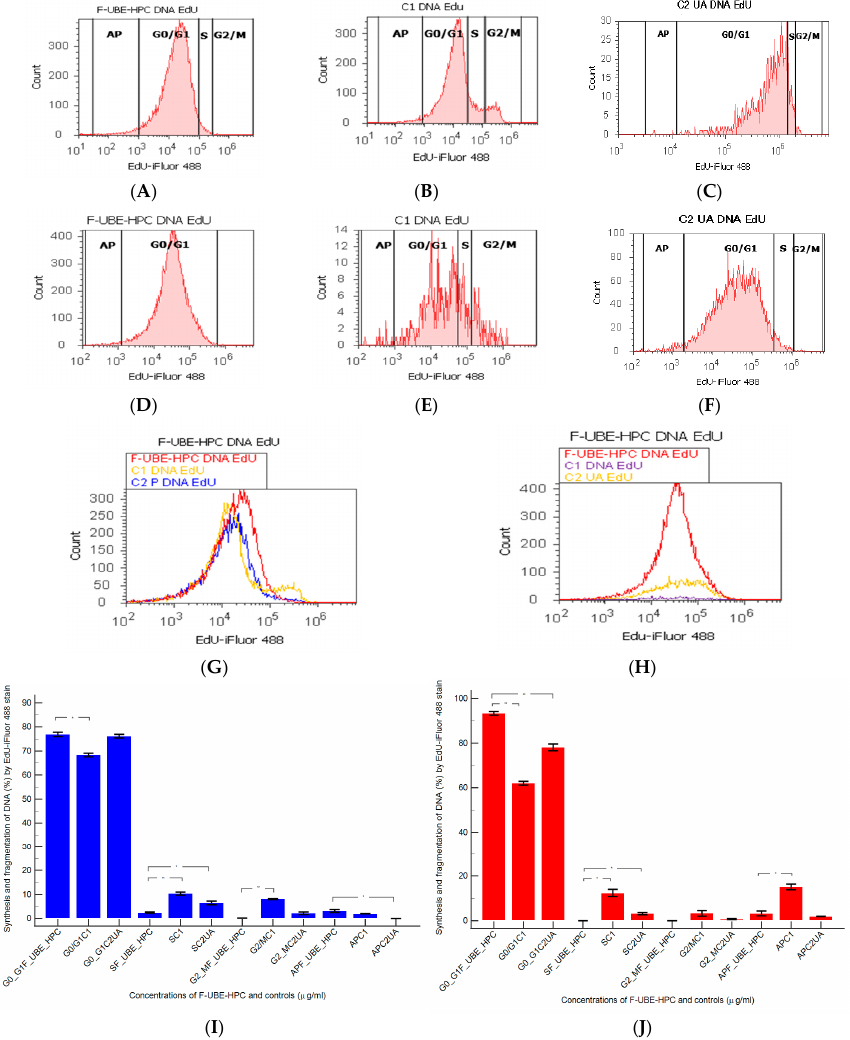
Figure 14. DNA synthesis (S) and DNA fragmentation (subG0/G1) after 24 h treatment with F-UBE- HPC in normal blood cell cultures ( A – C ) and CLS-354 tumor cells ( D – F ); EdU-iFluor 488 patterns of F-UBE-HPC ( A , D ); 1%DMSO negative control ( B , E ); 125 µg/mL UA positive control ( C , F ). F-UBE- HPC and controls extrapolated on EdU-iFluor 488 axis ( G , H ); statistical analysis of cell proliferation ( I , J ) in normal blood cell cultures and ( I ) CLS-354 tumor cell line ( J ). * p < 0.05 and ** p < 0.01 represent significant statistical differences between controls and sample made by paired samples t -test; C1—negative control with 1% dimethyl sulfoxide (DMSO); C2UA—positive control with 125 µg/mL usnic acid (UA). AP—apoptosis (subG0/G1); F-UBE-HPC—bioadhesive oral film loaded with U. barbata dry ethanol extract.